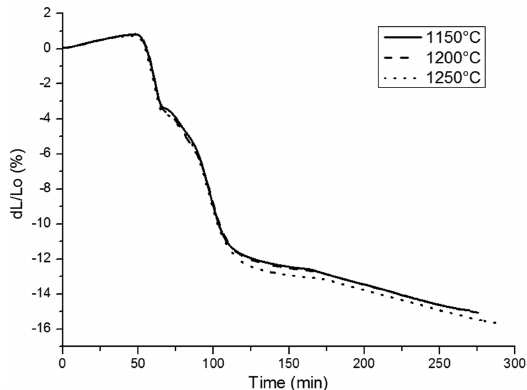
Figure 3. Dimensional changes of Hadfield samples sintered at 1150 °C, 1200 °C and 1250 °C. Author: Renan Schroeder.